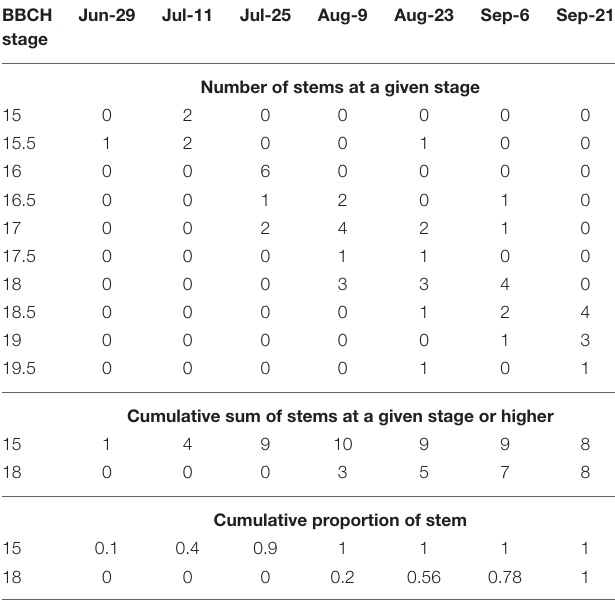
TABLE 3 | Raw explanatory data showing number of stems of Miscanthus × giganteus BBCH stage 15 or higher as measured during the 2016 growing season in Sorenson farm,